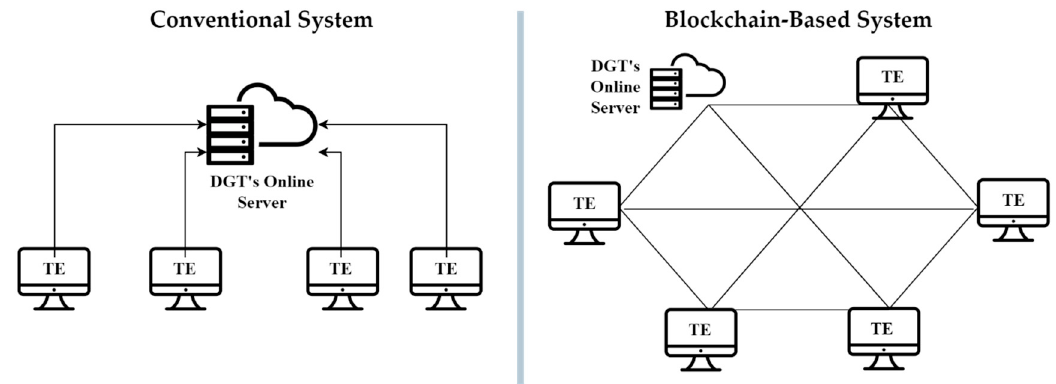
Figure 3. Comparison of conventional and blockchain-based Value Added Tax (VAT) systems.